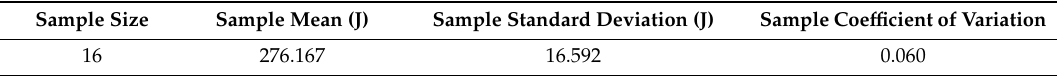
Table 8. Sample statistical data of transferred energy measured by the piston